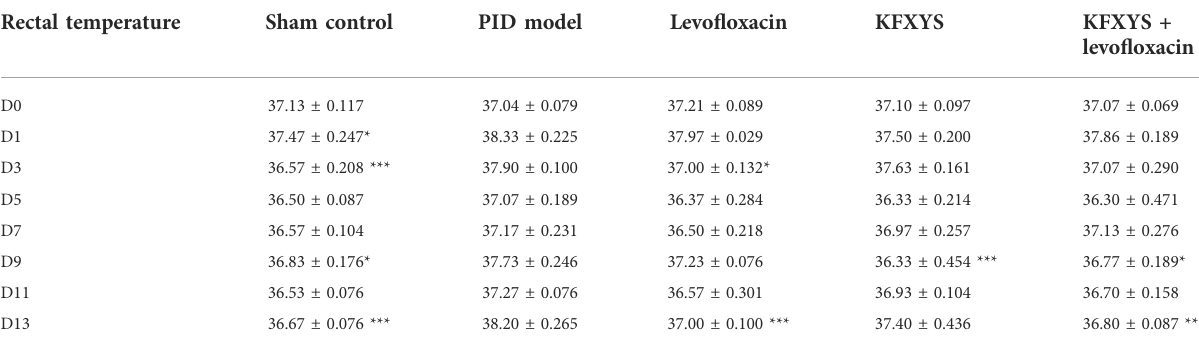
TABLE 2 Changes of rectal temperature of rats in acute in fl ammatory stage ( n = 4, ‾ X ± sem, ° C). Rectal temperature